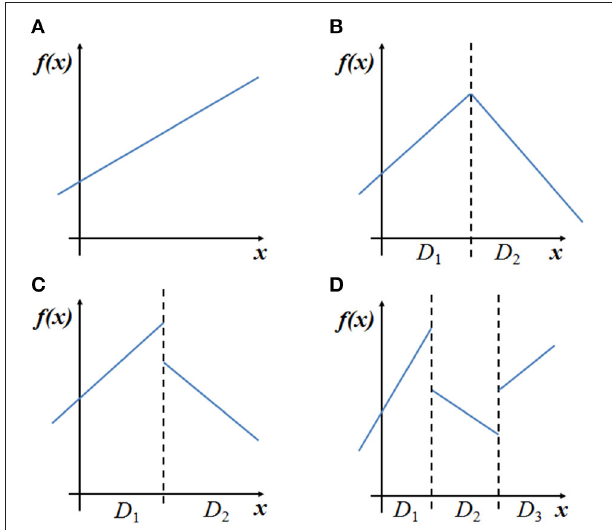
FIGURE 1 | In (A) a linear map. In (B) a piecewise-linear continuous map with two regimes. In (C) a piecewise-linear discontinuous map with two regimes. In (D) a piecewise-linear discontinuous map with three